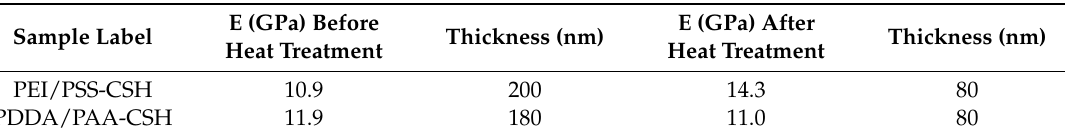
Table 6. Average Young’s modulus value and thickness of the samples comprising 25 bilayers made with different polymer complex sets.